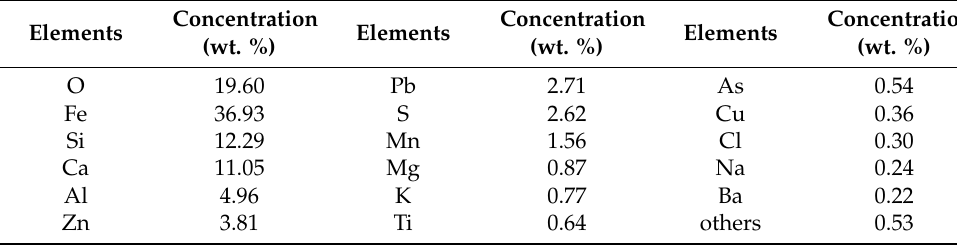
Table 1. Chemical composition of lead slag (wt. %).